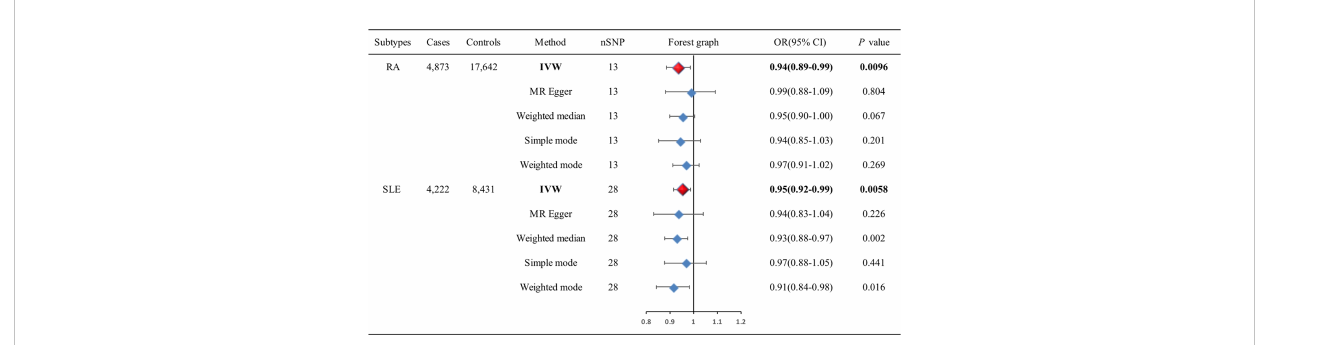
FIGURE 5 Associations of genetic liability to RA and SLE with risk of BC in the East Asian individuals. BC, breast cancer; CI, con fi dence interval; IVW, inverse variance weighted; OR, odds ratio; RA, rheumatoid arthritis; SLE, systemic lupus erythematosus; SNP, single-nucleotide